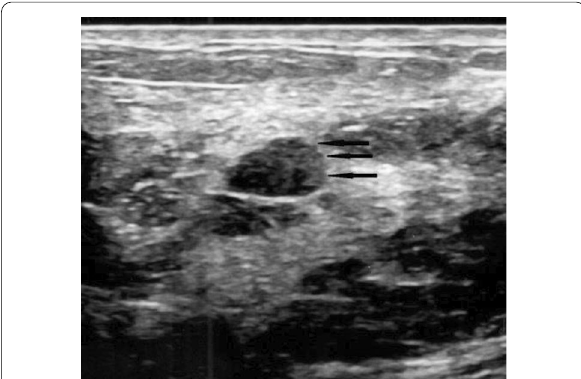
Fig. 3 Lesion that appeared as well defined opacity on digital mammography, revealed microlobulated margins (Black arrows) on HR USG and was let out invasive Ductal carcinoma on Trucut biopsy in a patient of 38 years of age